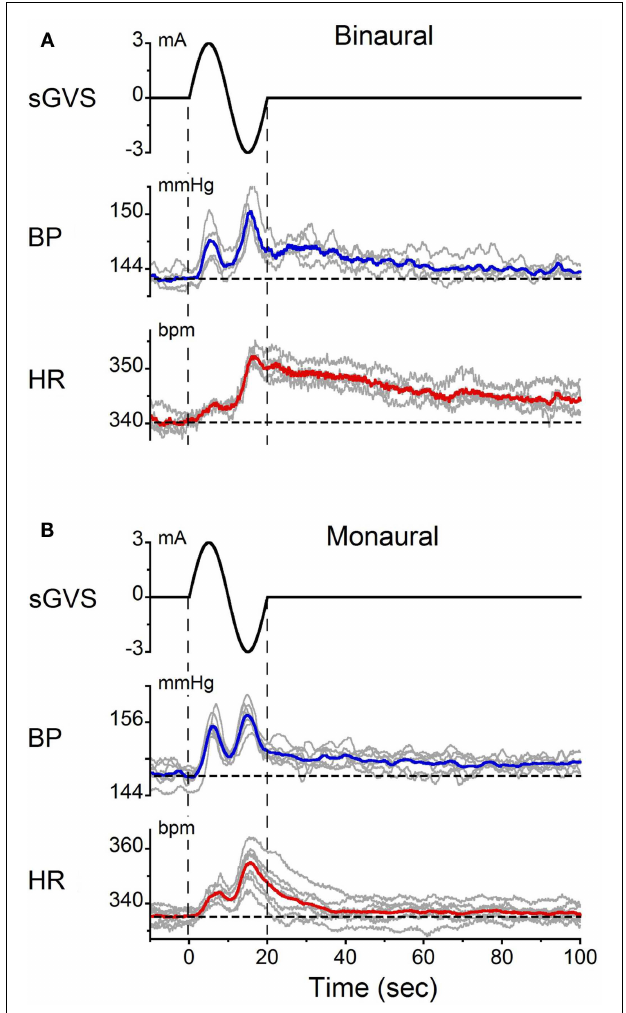
FIGURE 3 | Changes in BP and HR induced by single cycles of sGVS at 0.05Hz (20s) given (A) binaurally and (B) monaurally .The stimulus was repeated 10 times at 2min intervals.The data were synchronized from the onset of sGVS. Gray traces – responses to individual stimuli. Blue and red traces – averaged responses for BP and HR, respectively.Vertical dashed lines indicate the onset and offset of sGVS. Horizontal dashed lines show the average BP and HR at the onset of sGVS. Note the double oscillations induced by each sinusoid and the prolonged decline in BP [blue traces in (A,B) ] and HR [red traces in (A,B) ] over 120s.